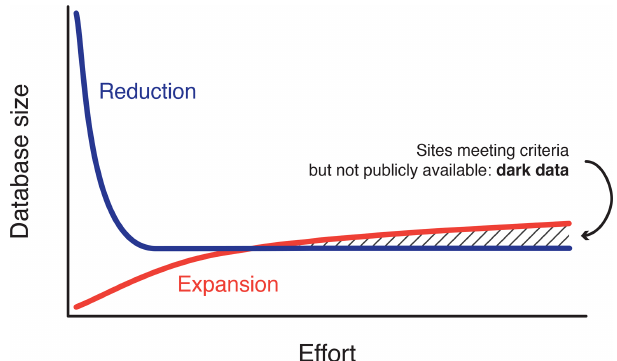
Figure 1. Data synthesis approaches. In the expansion approach the database size increases slowly as records are added. The database size follows an opposite pathway using the reduction approach and reaches a stable size more quickly, with less effort. Since the expan- sion approach is not restricted to data that are available in the public domain, this approach may lead to a database that includes data that are not publicly available (dark data). The reduction approach on the other hand is arguably more objective, can be automated and is therefore more efficient. This approach also encourages good data